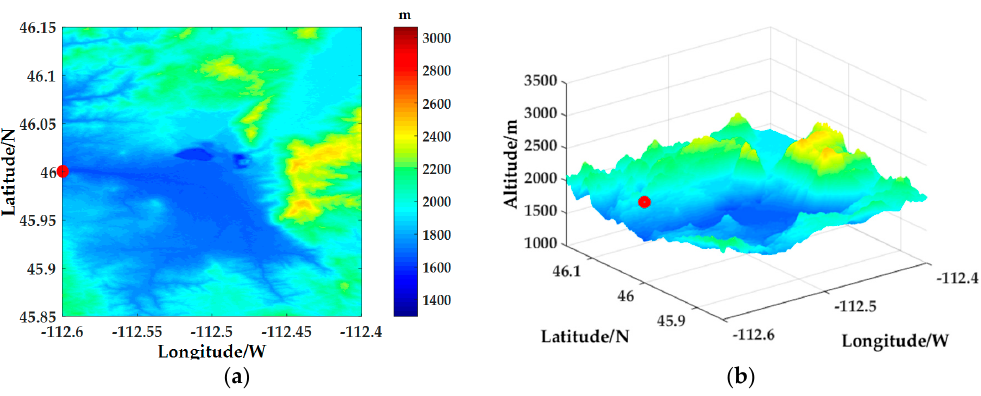
Figure 5. Aircraft position setting and elevation value display in radar operating range: ( a ) Two dimensional elevation value display; ( b ) 3D elevation value display.